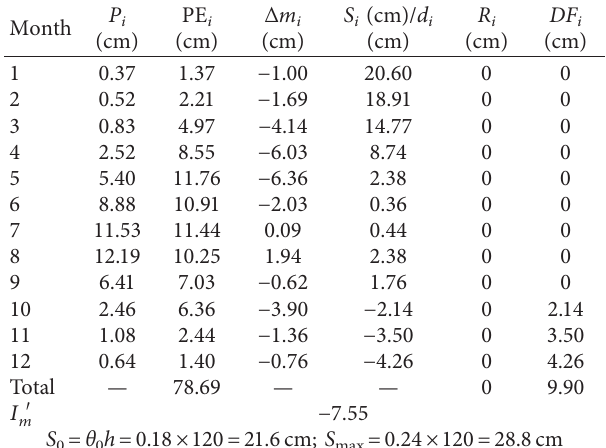
Table 1: Meteorological station information. Longitude Latitude Meteorological station Elevation